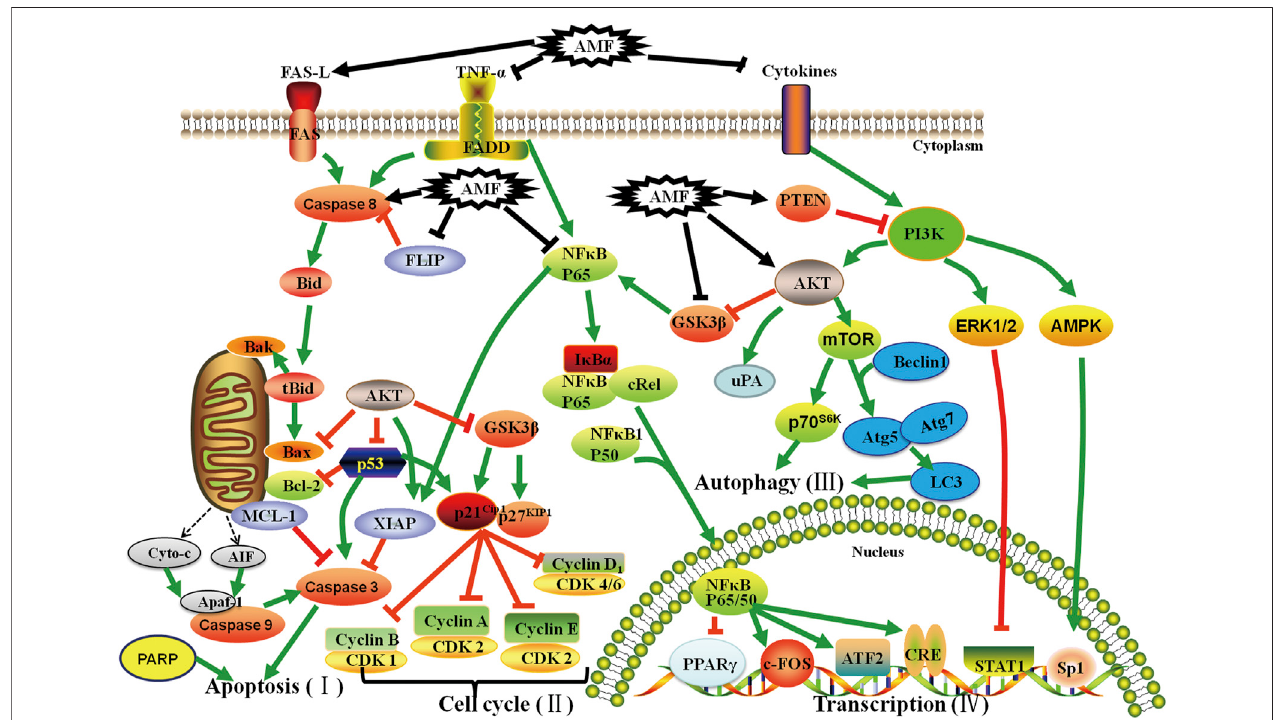
FIGURE 2 | Effect of AMF on Apoptosis (I), Cell cycle (II), Autophagy (III) and Transcription (IV) of various cancers through different molecular signaling pathways. AMF: Amento fl avone; T: Inhibition; ↑ : Activation; T: Inhibition by AMF; ↑ : Activation by AMF.